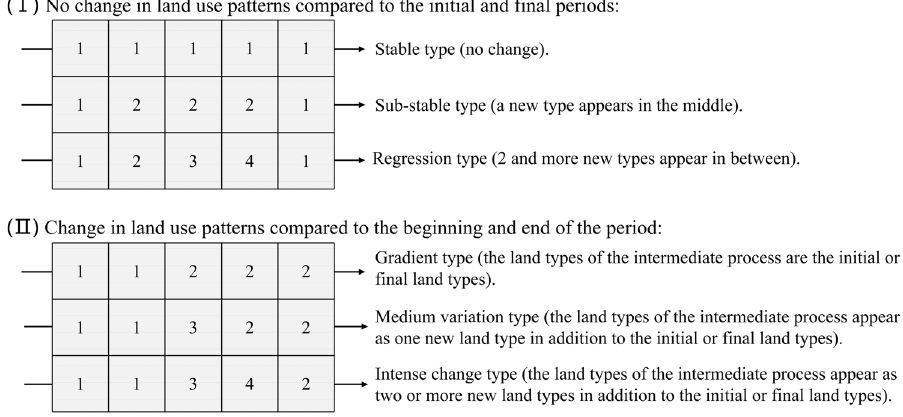
Figure 3. Types of land use change trajectory. Software: PowerPoint 2021. URL: https:// www. micro soft. com/ zh- cn/.